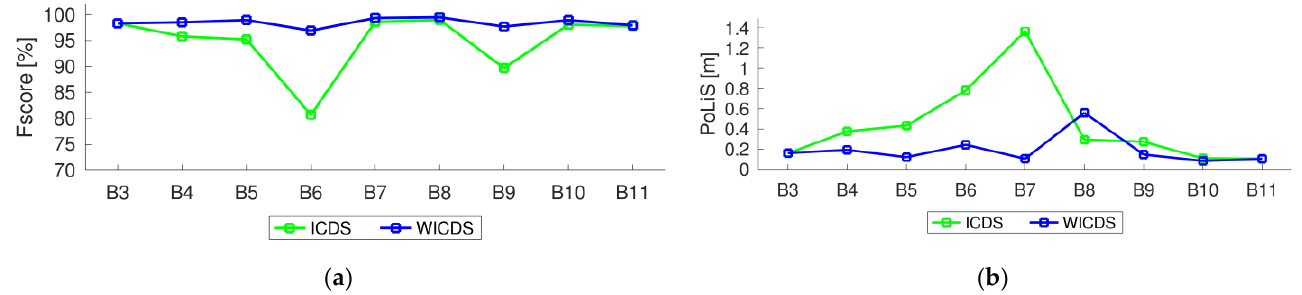
Figure 15. Quality metrics for buildings B3 – B11 using the ICDS and WICDS methods. Plots of F score ( a ) and PoLiS ( b ) metrics.